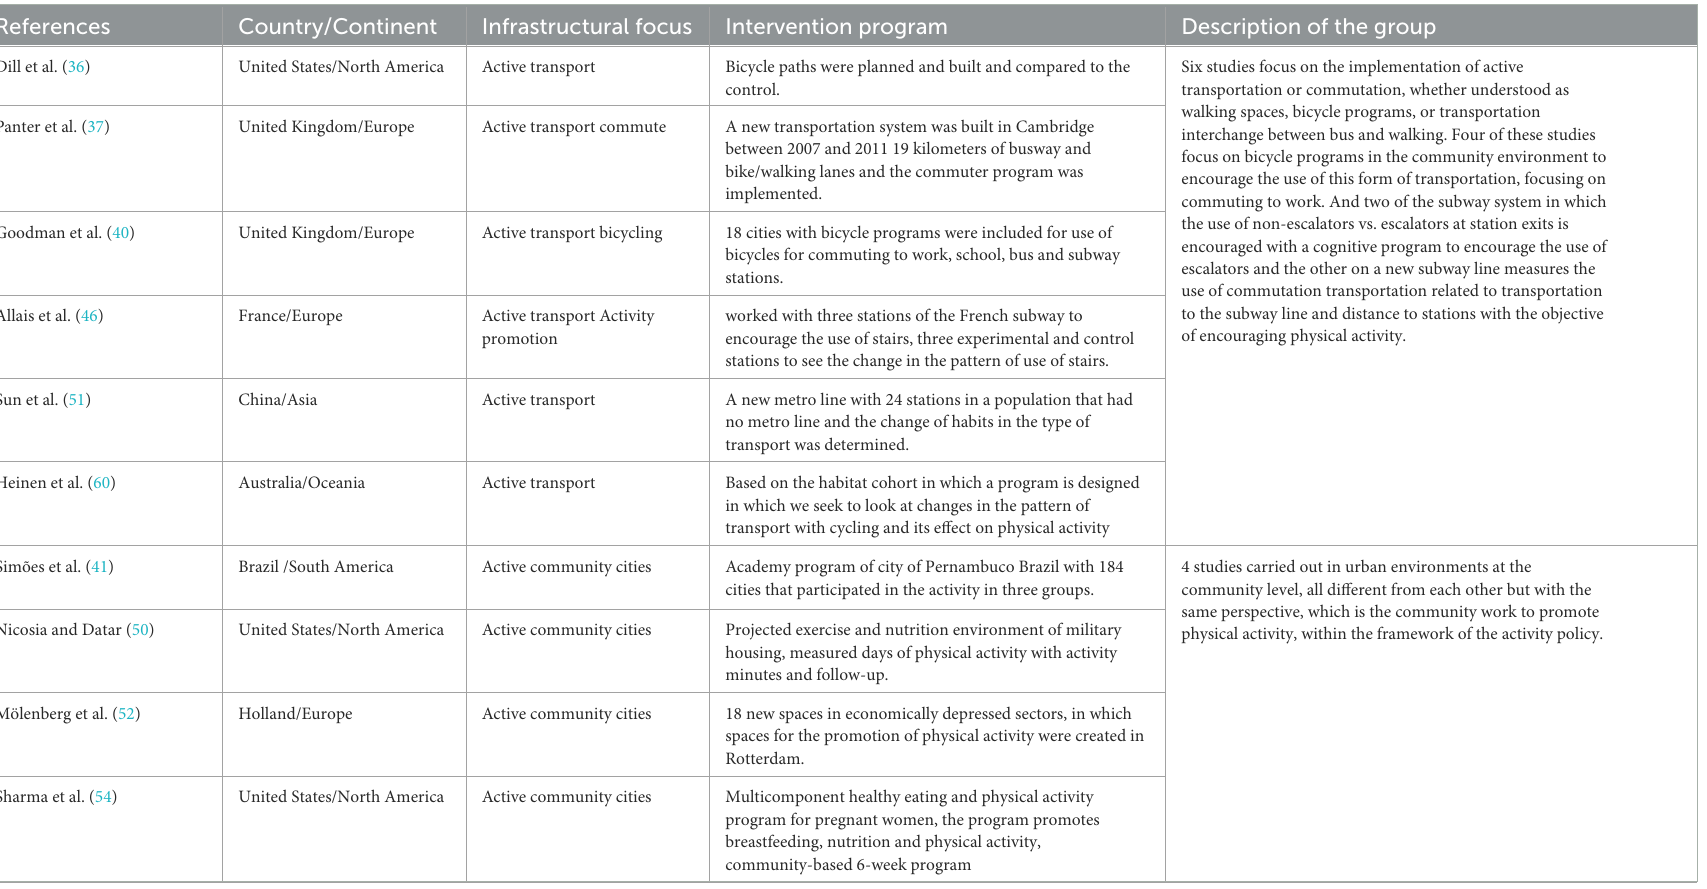
TABLE 1 Characteristics of the studies included and areas of